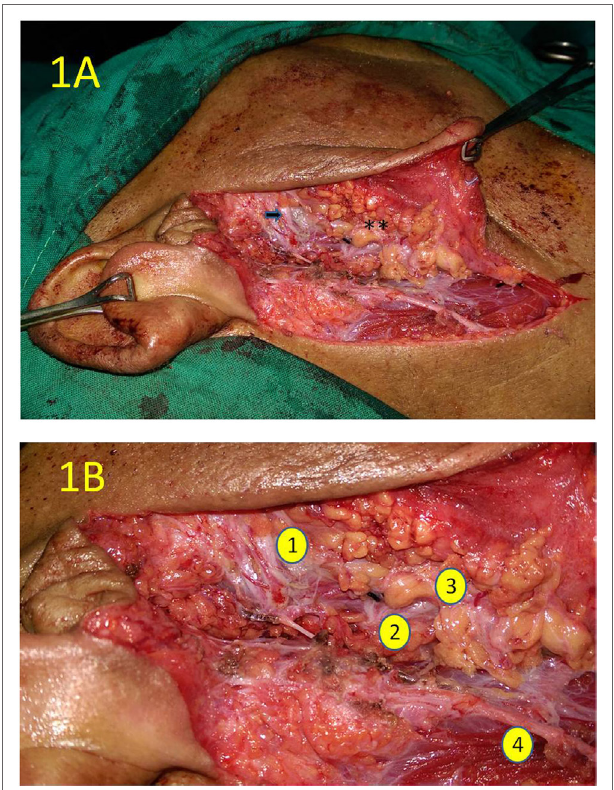
FigUre 1 | The intraoperative photograph of right parotidectomy at the completion of upper quadrantectomy. (a) The zygomatic branch of the facial is skeletonized “arrow.” The transected surface of the lower gland quadrant is marked by the double asterix. (B) Close-up view of the same operative field as (a) showing the zygomatic branch of the upper trunk of the facial nerve (1), the origin of the lower trunk of the facial nerve (2), the transected surface of the lower quadrant of the gland (3), and the great auricular nerve